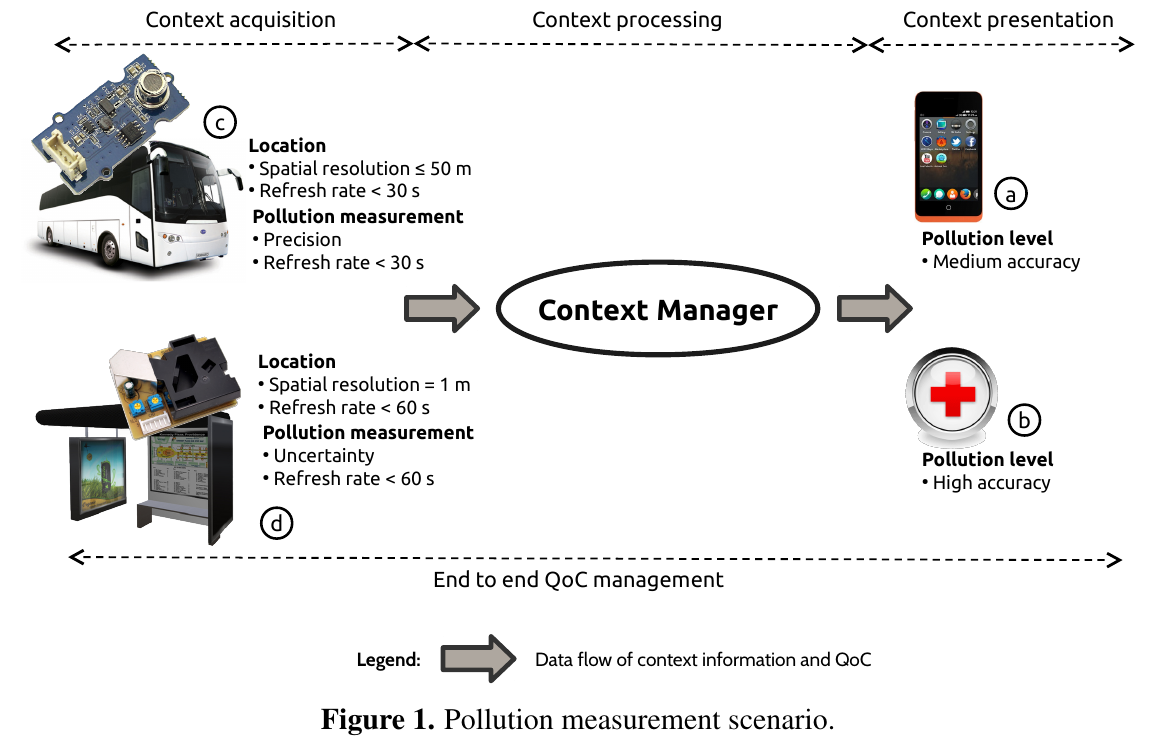
Figure 1. Pollution measurement